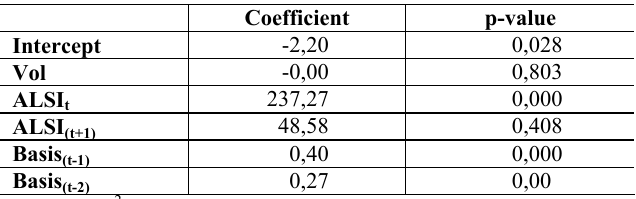
Table 1: Regression summary of implied volatility on basis – ALSI